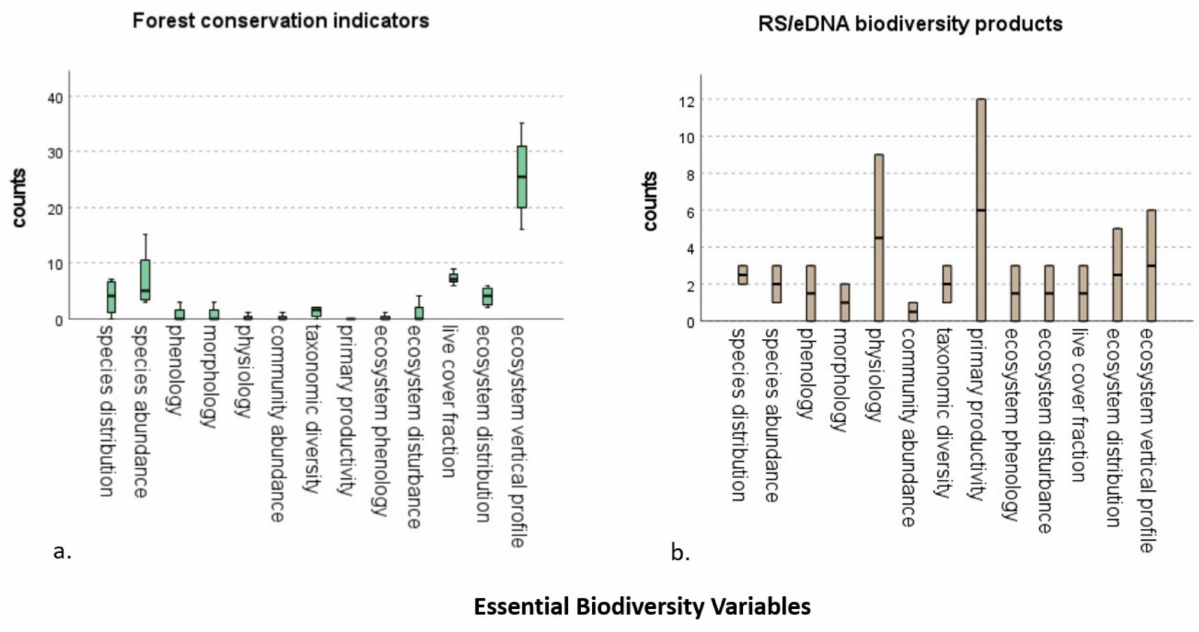
Figure 5. Distribution of the number of ( a ) forest conservation indicators and ( b ) RS/eDNA biodiver- sity products across the different Essential Biodiversity Variable